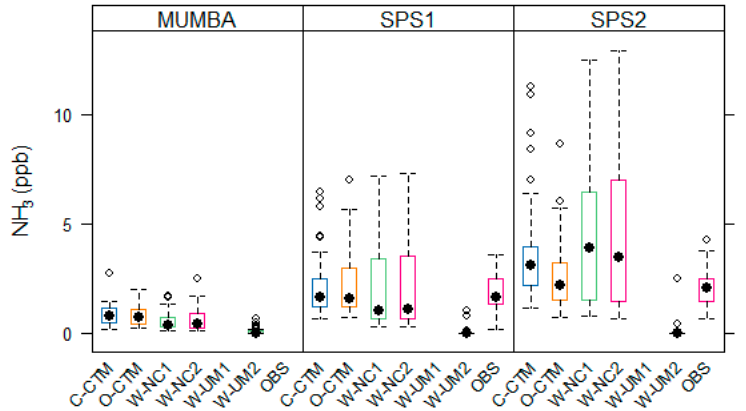
Figure A3. Composite diurnal cycles for observed and modelled hourly average PM 2.5 concentration in µgm − 3 during each campaign (upper panel) and Taylor diagrams for hourly PM 2.5 from each campaign period (lower panel).